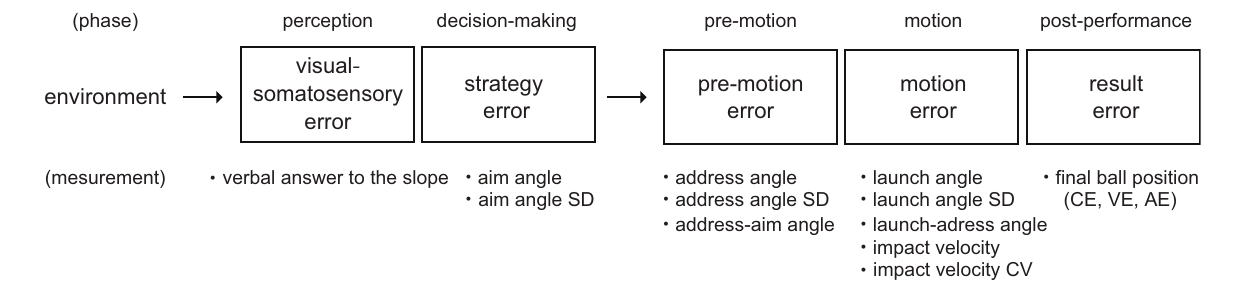
Frontiers in Psychology |